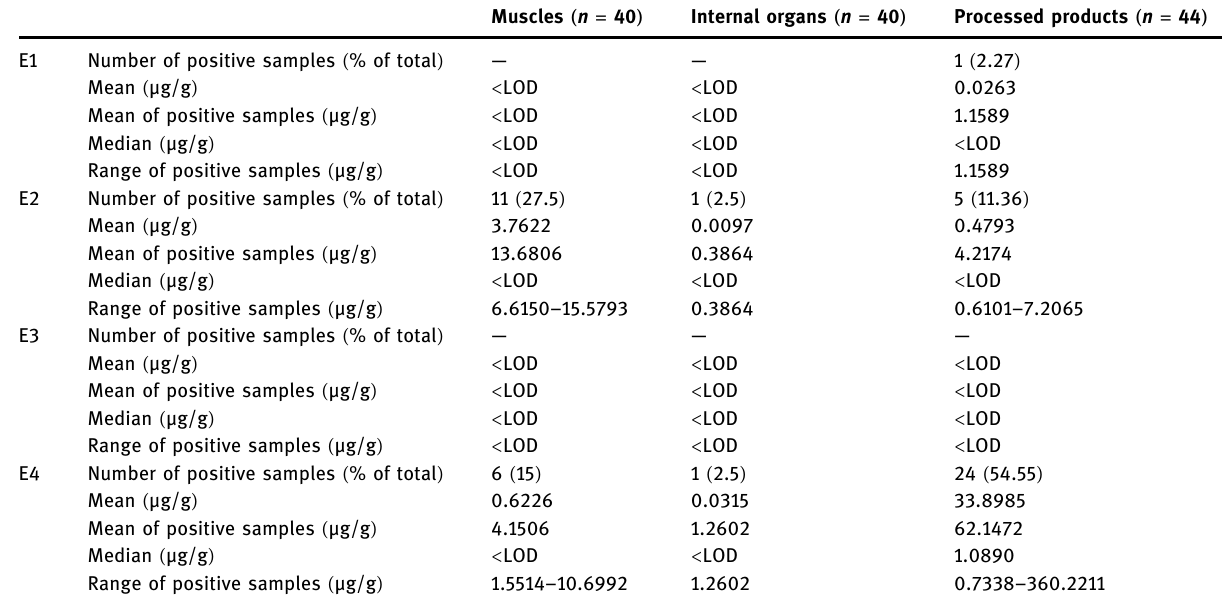
Table 4: Occurrence of estrogen residues ( µg/g ) in beef samples Muscles ( n = 40 ) Internal organs ( n = 40 ) Processed products ( n = 44 )